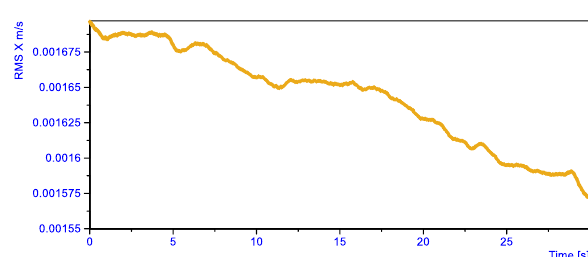
Fig. 10. The diagram of the effective RMS velocity of vibrations along the Z axis; n = 3600 rpm, M =75 Nm, α wtr = 5° Fig. 5. The diagram of the vibration velocity in the X axis; n = 3600 rpm, M =75 Nm, α wtr = 5°